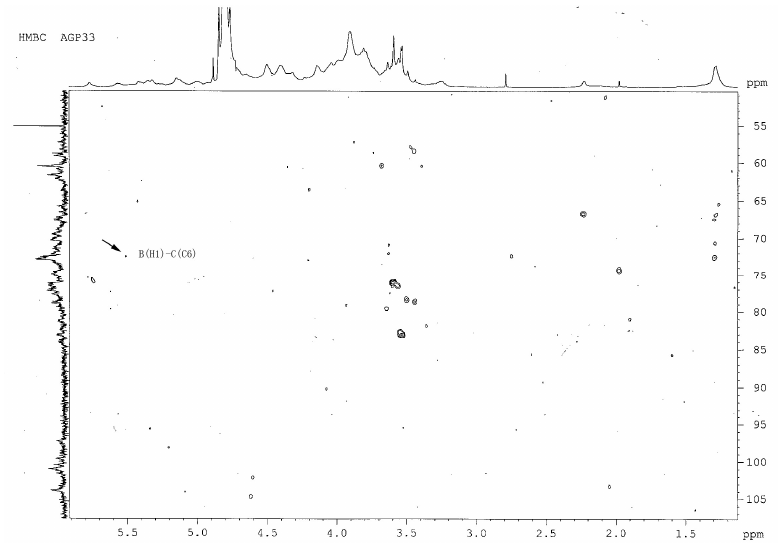
Figure 5. 1 H- 13 C-HMBC spectrum of AGP33. The cross-peaks demonstrate that 1,4- D -Gal p (residue B) links directly to 1,6- D -Glc p (residue C).